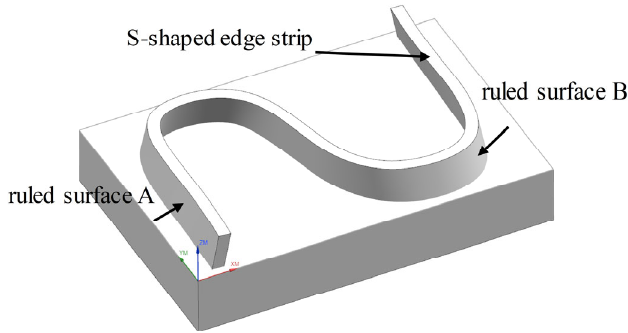
Figure 13. The geometry of the S ‐ shaped edge strip.